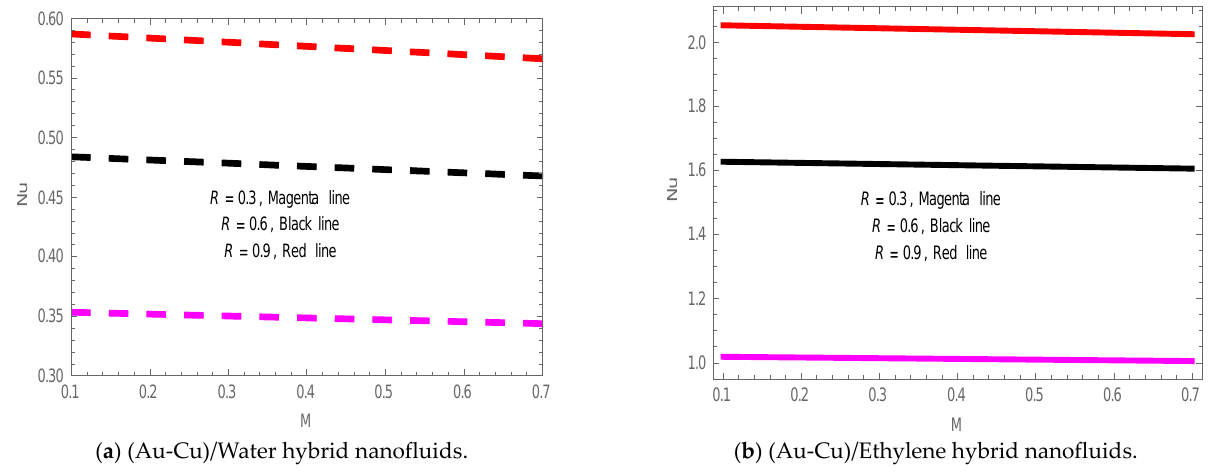
Figure 13. Nu for dissimilar values of R .